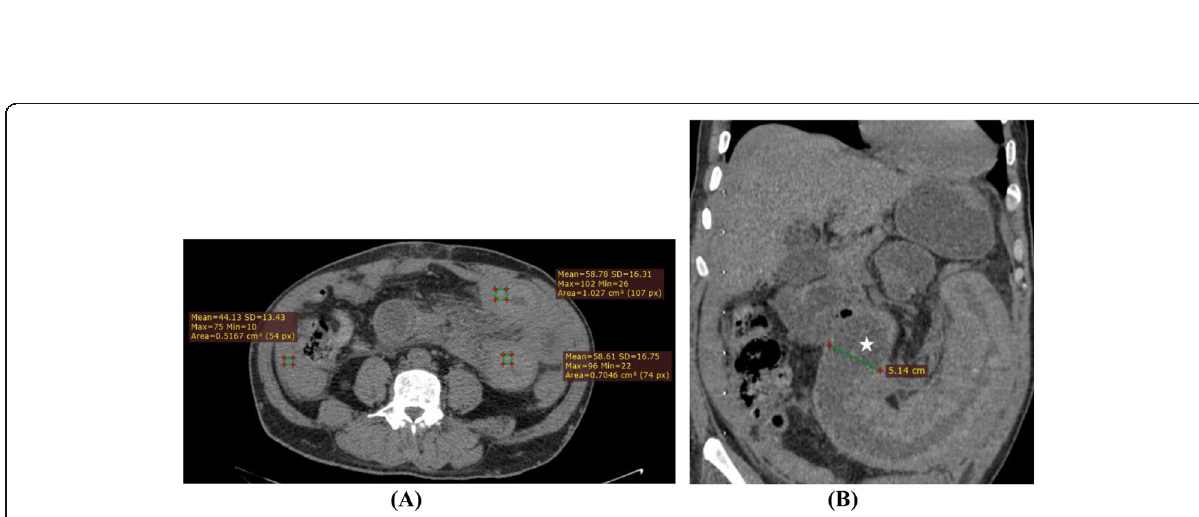
Fig. 16 CT of abdomen and pelvis in non-contrast phase. a Axial image and b coronal reformatted image in a 72-year-old male patient with given history of warfarin intake, diagnosed with intra-mural small bowel hematoma, showing hyperdense mural thickening with attenuation density of 58 HU on non-contrast CT phase and free intraperitoneal fluid collection of high attenuation (44 HU) with consequent proximal small bowel dilatation